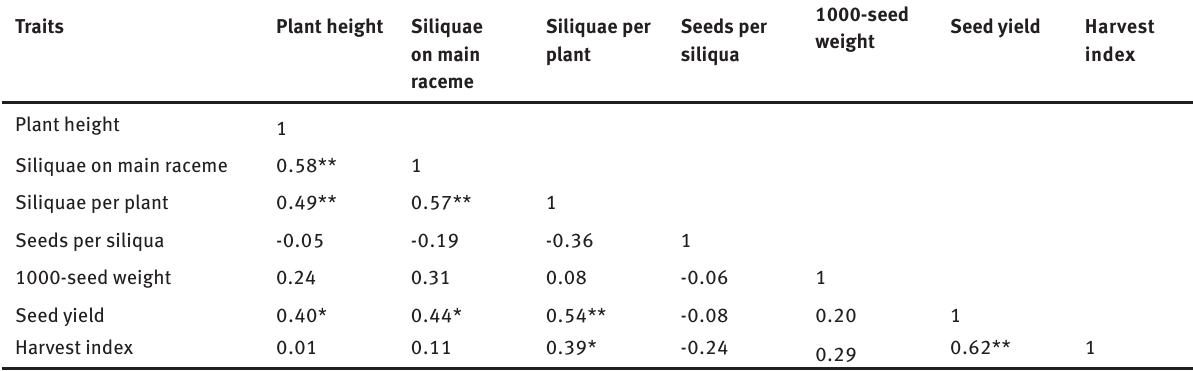
Table 6: Pearson correlation coefficient estimates of seed yield and its components based on heterobeltiosis of the crosses